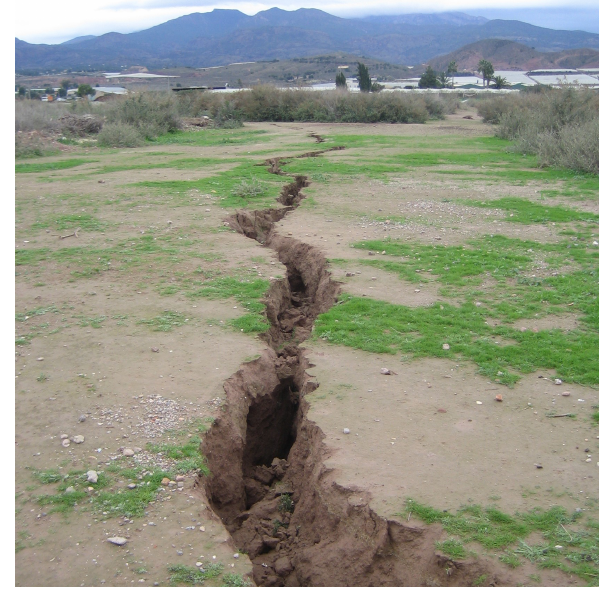
Figure 7. Image of the fissure that appeared in Totana.